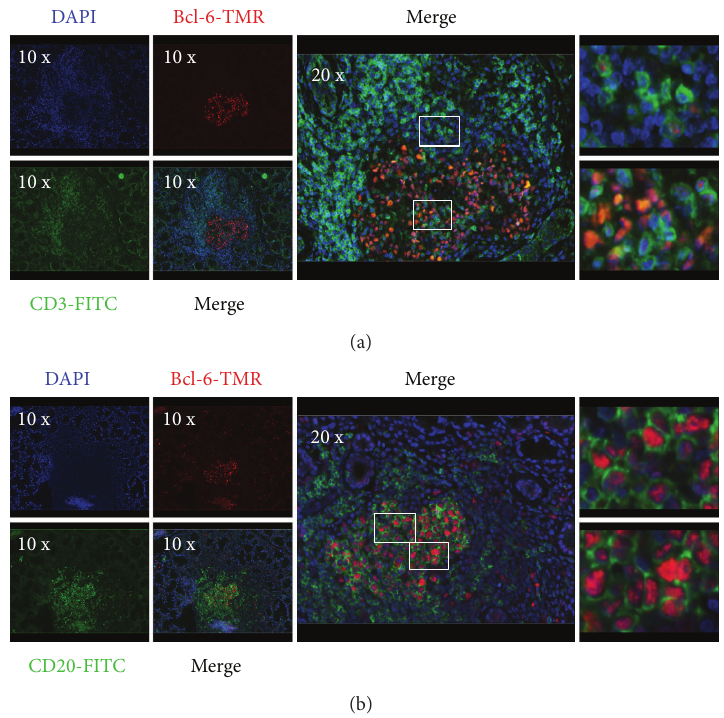
Figure 4: Immunofluorescence demonstration of the coexpression of CD3/CD20 and T FH -related molecule Bcl-6 in LSG biopsy. Double immunofluorescence stainings of LSG biopsy sections from pSS patients with Bcl-6 plus CD3 (a) and Bcl-6 plus CD20 (b). Boxed areas indicate the localization of the zoomed-in images in the right, in the same order (from top to bottom). The representative images were made from a biopsy specimen that belonged to the pSS group with FS = 3. Objectives used: 10x/0.3 NA; 20x/0.5